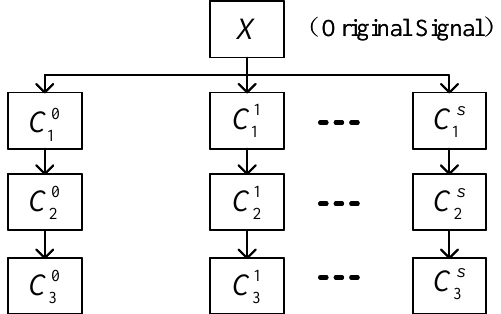
Figure 3. Schematic diagram of ISVDP.